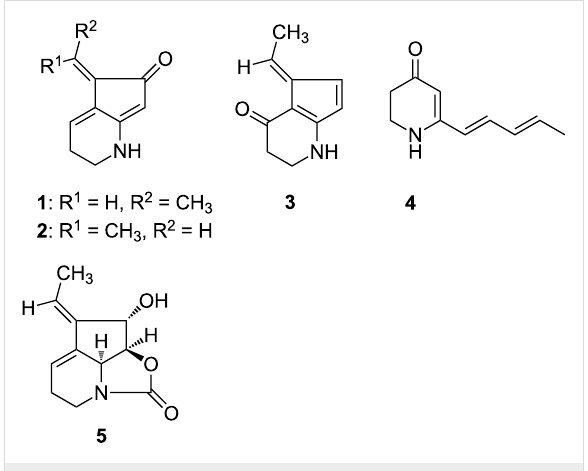
Figure 1: Alkaloids produced by Streptomyces strain